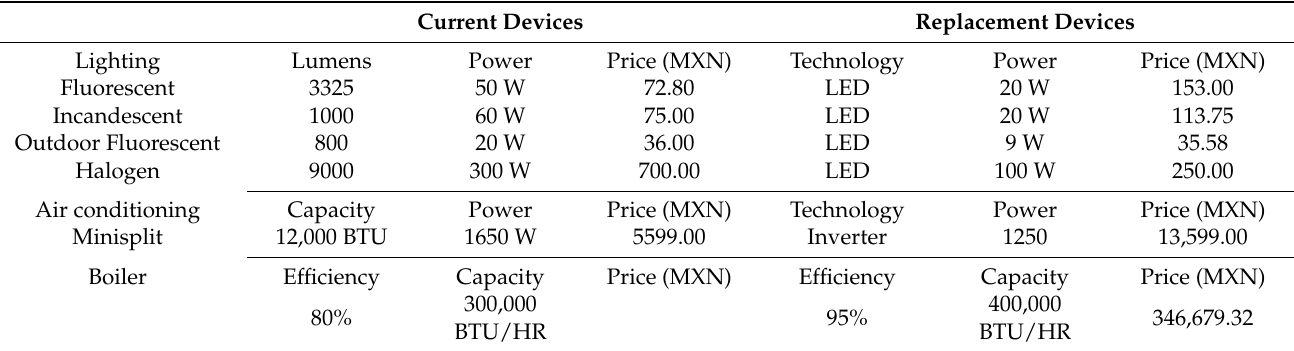
Table 3. Technical characteristics of current and replacement